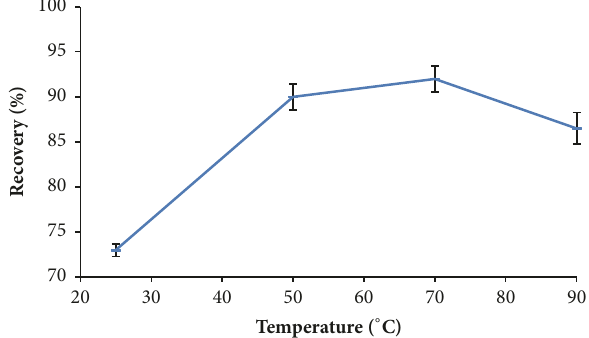
Figure 3: Effect of various reaction temperatures on formaldehyde recovery (mean ± sd, n = 2).